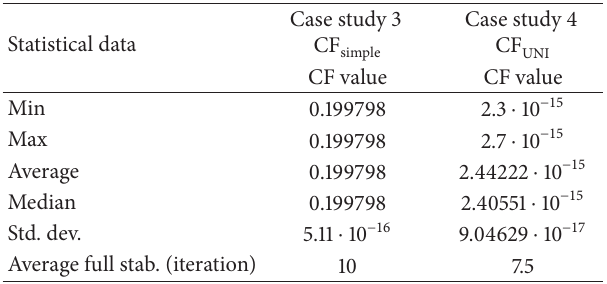
Table 6: Simple CF statistics: joined case studies 3 and 4, delayed logistic as CPRNG/controlled system.